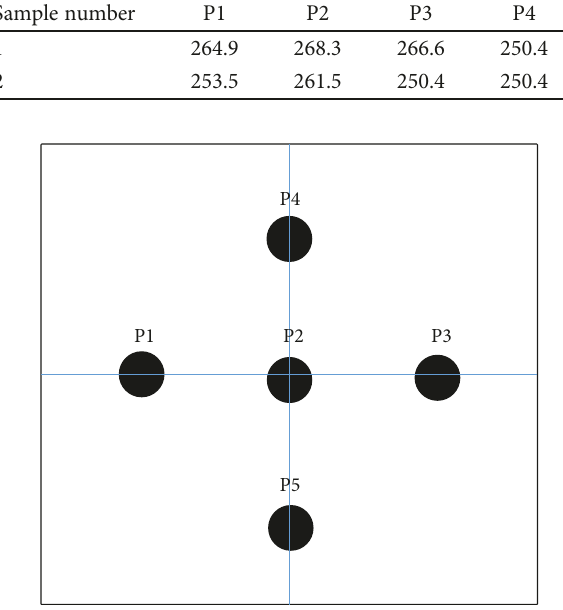
Figure 23: Five sample points of parts for microhardness